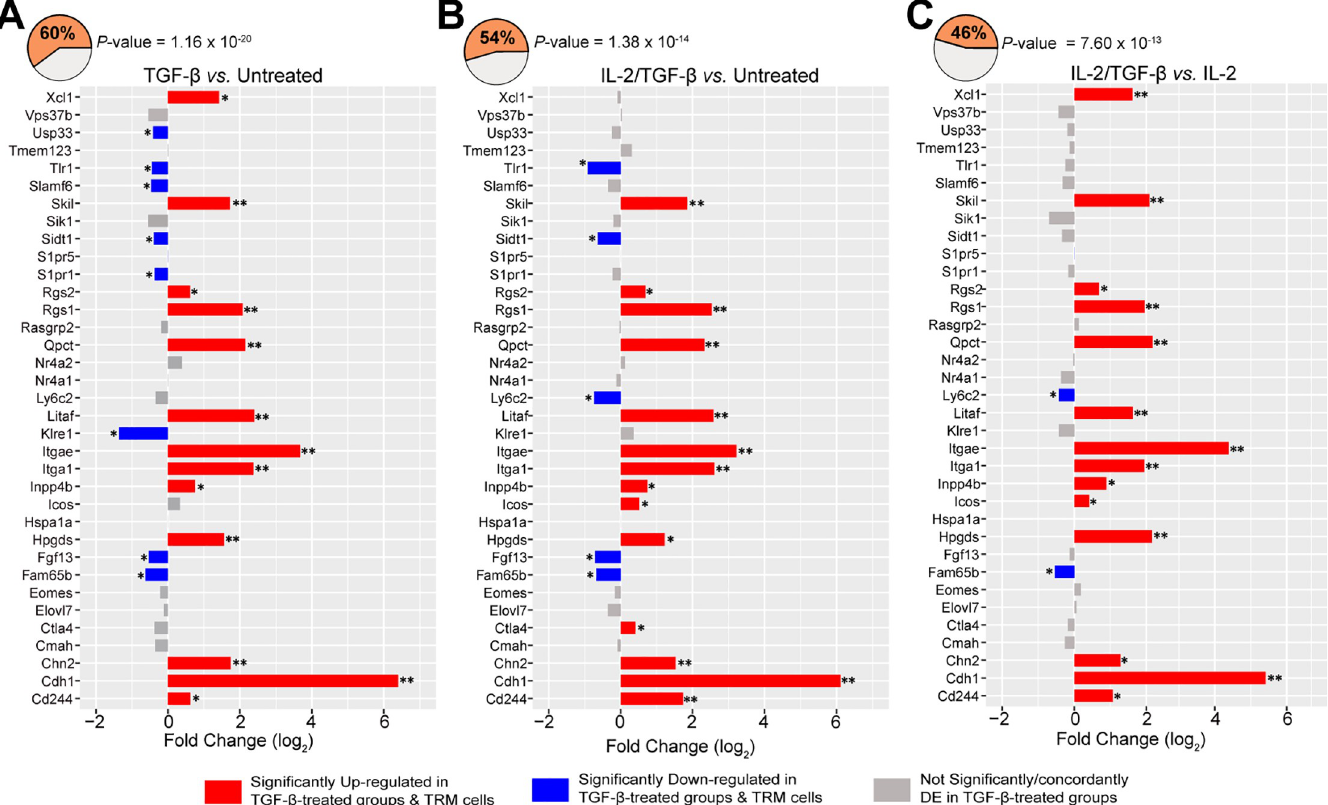
Fig 4. TGF- β induced transcriptional profiles are enriched for the TRM-related signature genes identified in murine TRM cells. (A-C) The bar plots show the log2 fold change in expression (x-axes) of the 35 TRM-related signature genes in each of the pairwise comparison of the TGF- β -treated groups vs . TGF- β -untreated groups. The bars are colour-coded based on their expression in both TRM cells and TGF- β -treated groups. Consistently up-regulated genes are depicted in red, and down- regulated genes are shown in blue. Grey represents genes that were either not significantly DE in TGF- β -treated groups vs . TGF- β -untreated groups or whose direction of DE was not concordant between TRM cells and TGF- β -treated groups. The numbers in the pie chart denote the percentage overlap between the genes in the TRM- related signature and genes DE (FDR < 0.05) in the TGF- β -treated groups. The P -values next to the pie charts denote the enrichment P -values calculated via bootstrapping